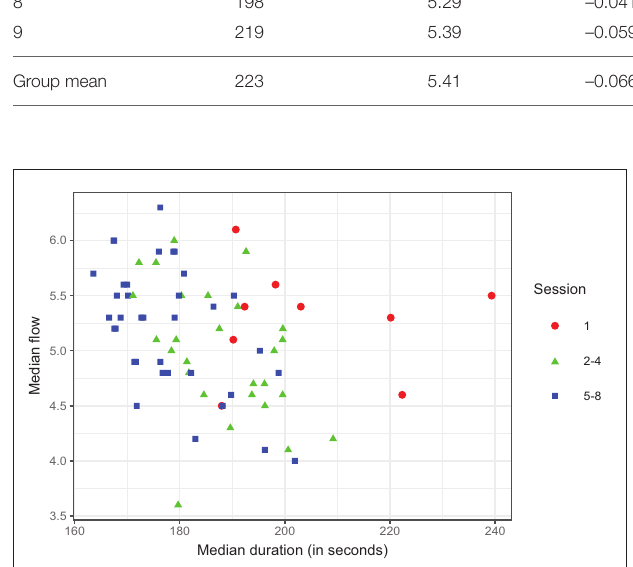
FIGURE 5 | Duration and flow over sessions grouped: 1 (Introduction+physiological measurements), 2–4 (training), 5–8 (physiological measurements), N =